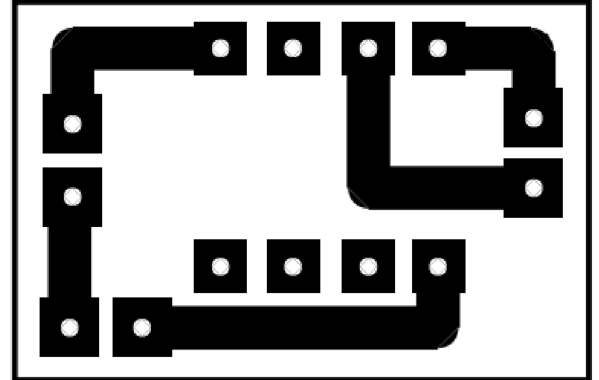
Fig. 2 CAD model of device